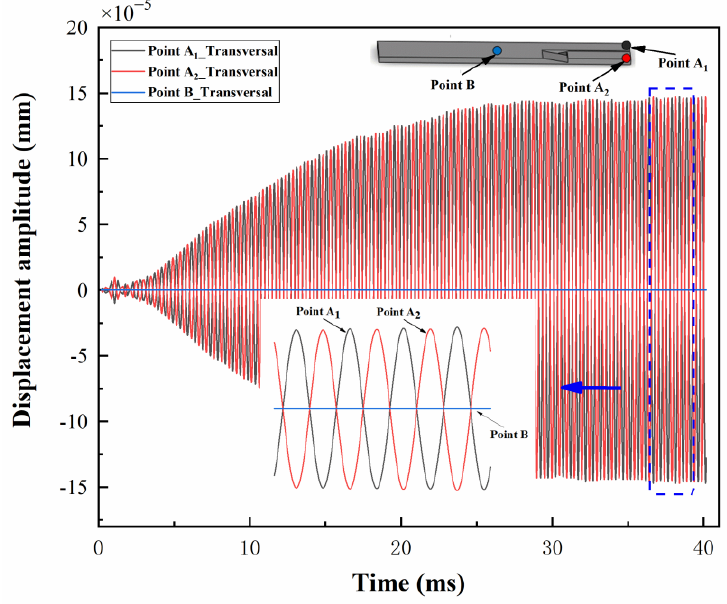
Figure 7. The transversal vibration displacements of the micro-stirrer at different points vs. time.